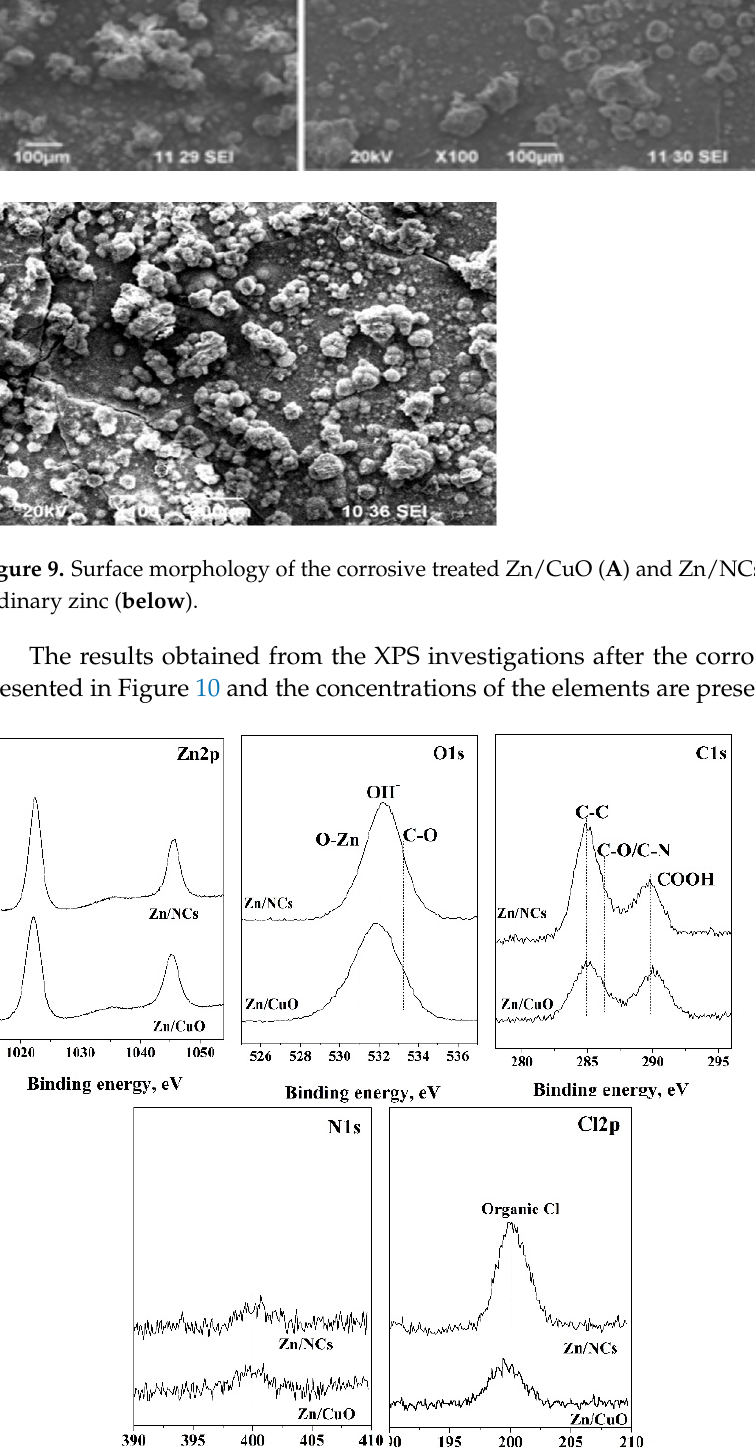
Figure 10. XPS studies of both samples after 55 days’ immersion in the corrosion medium.